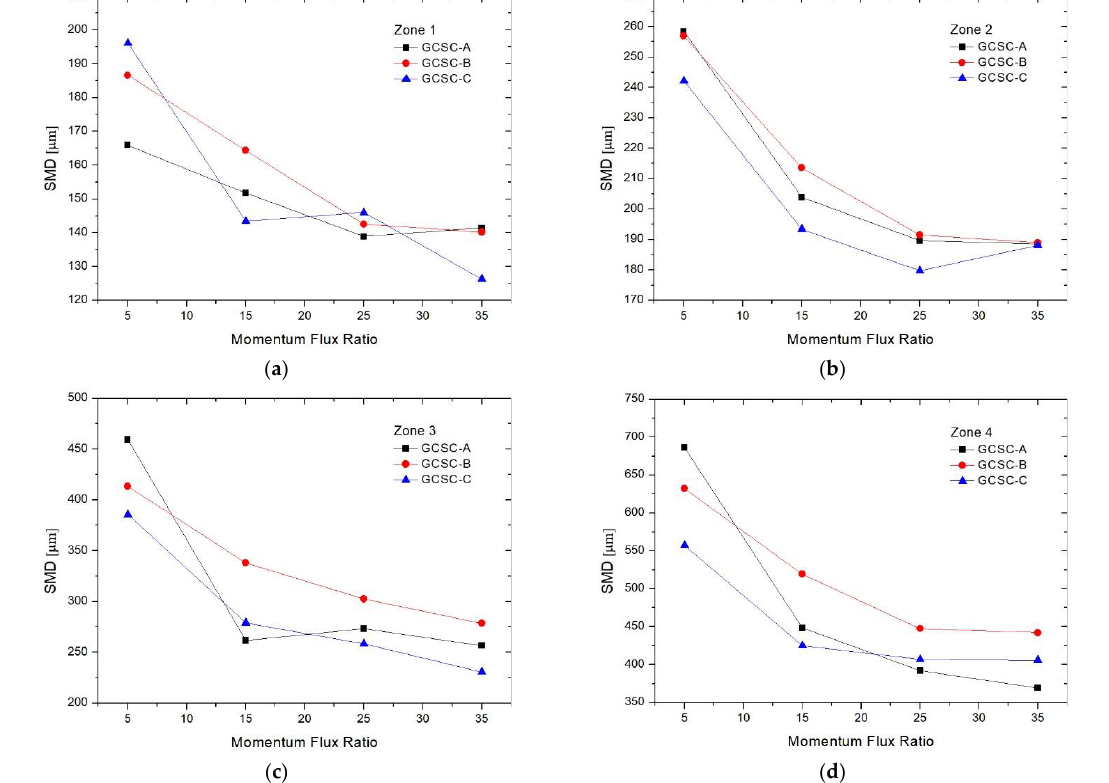
Figure 8. SMD according to injector types and MFR: (a) Zone 1; (b) Zone 2; (c) Zone 3; (d) Zone 4.